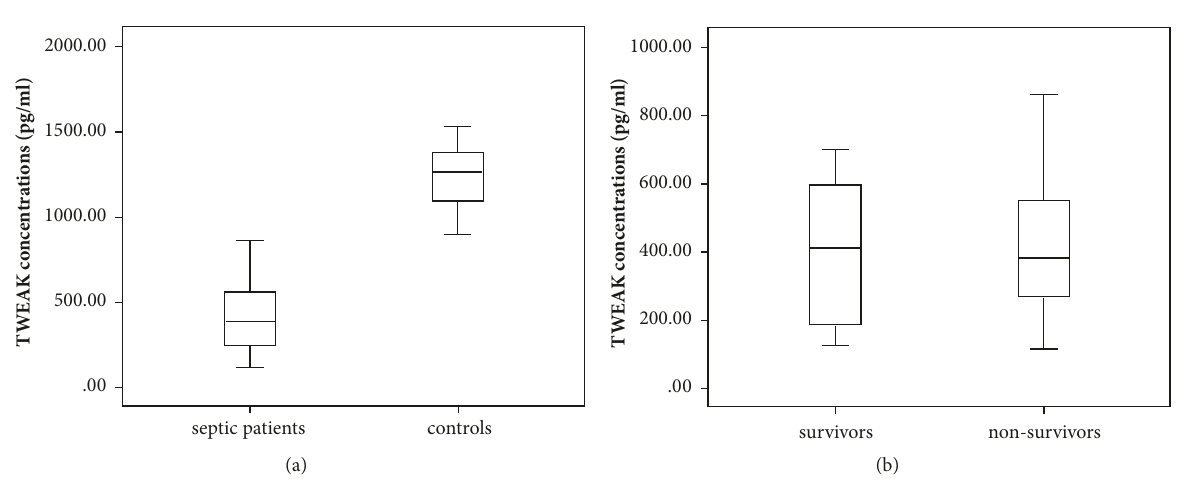
Figure 1: Serum TWEAK concentrations at ICU admission. (a) Serum TWEAK concentrations were significantly lower in septic patients compared to healthy controls ( p < 0.001). (b) There was no statistical significance between survivors and nonsurvivors for TWEAK concentrations ( p =0.642).